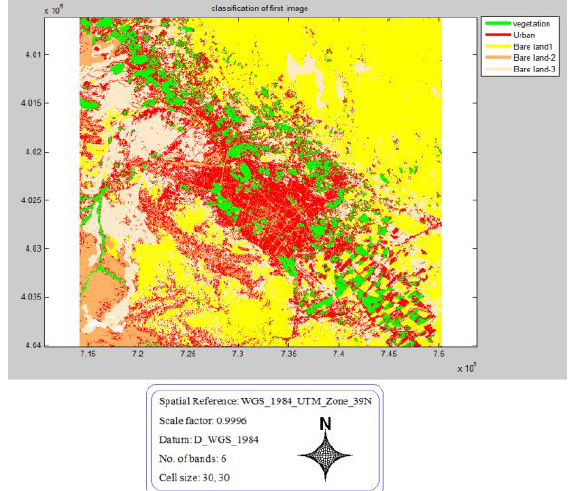
Figure 4. The first classified image related to April 22, 1987